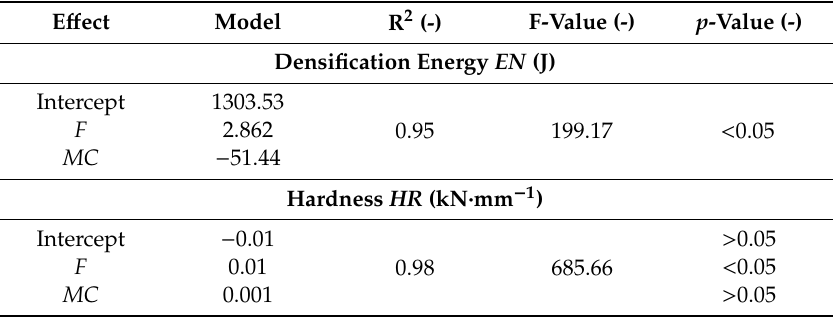
Table 6. Regression results of densification energy and hardness of ground sunflower stalk briquettes with the e ff ects of force and moisture